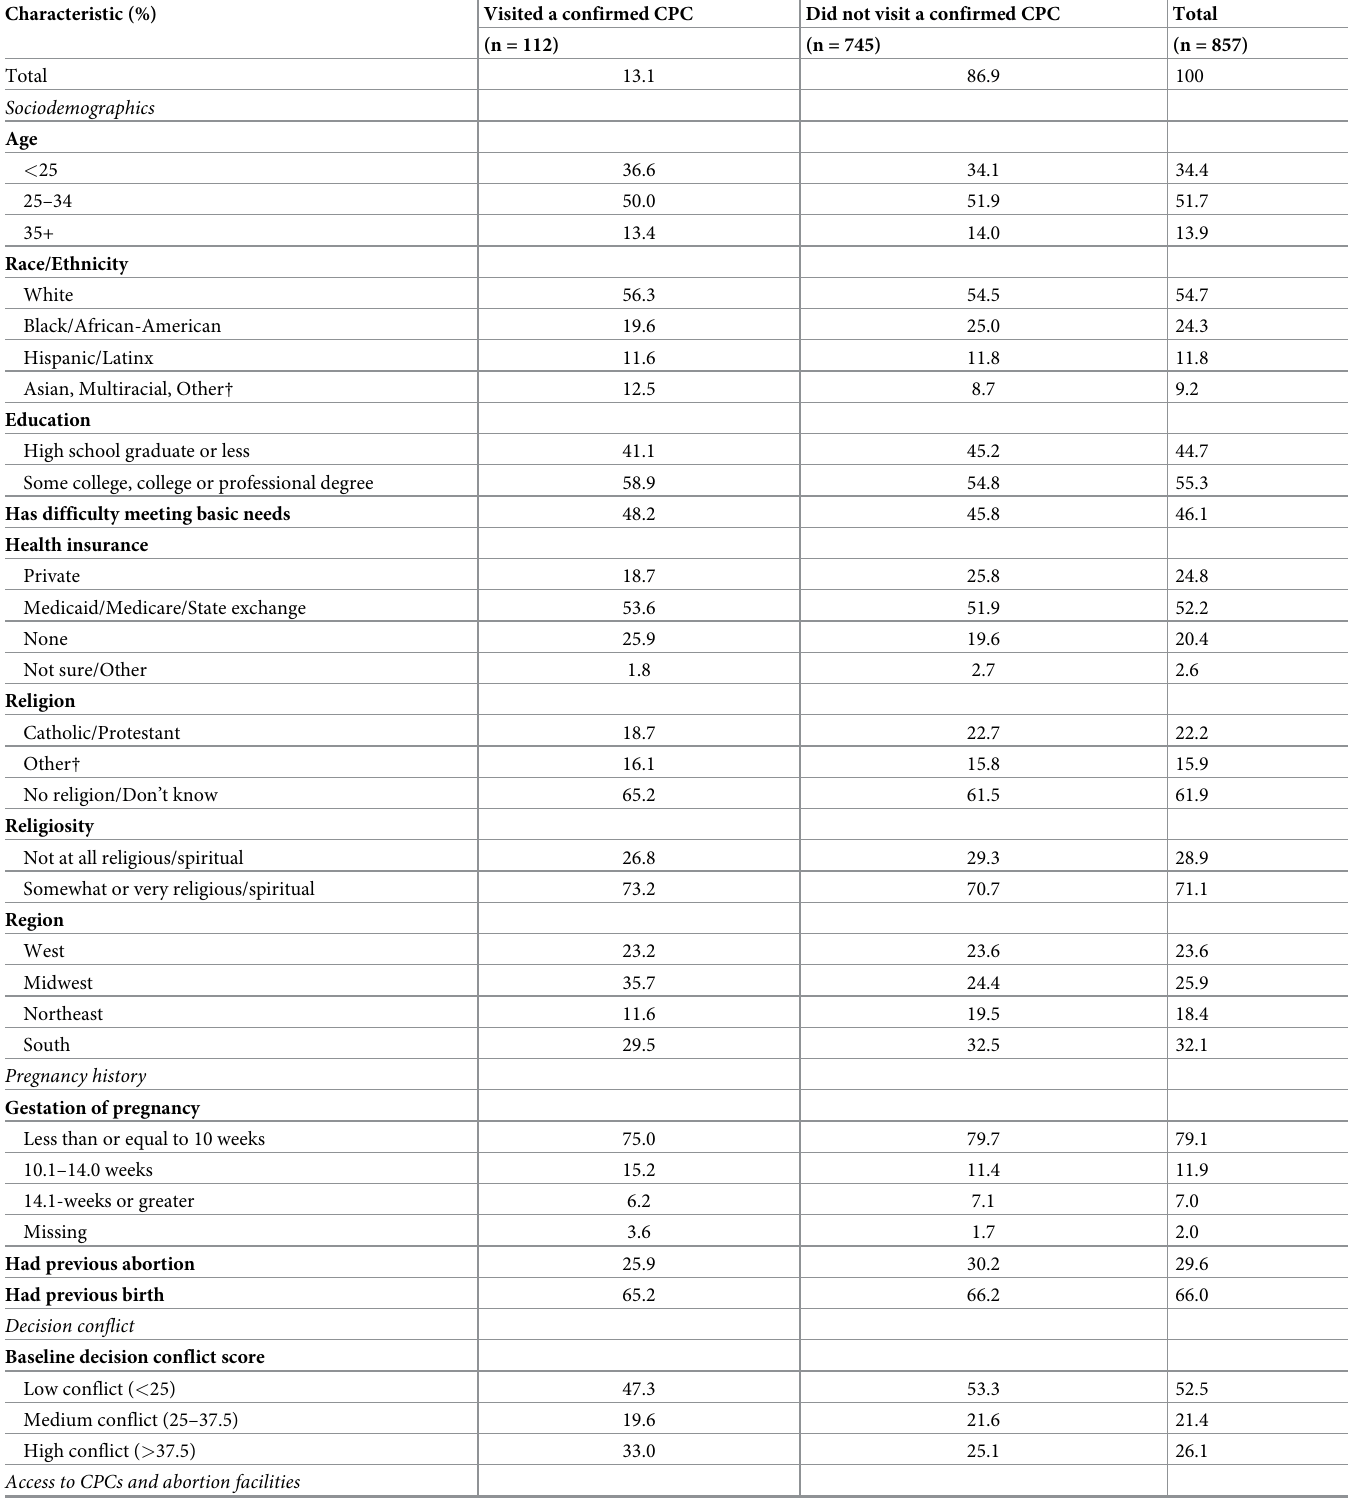
Table 1. Sociodemographic, pregnancy, and residence characteristics of participants at baseline, by confirmed crisis pregnancy center visit. Characteristic